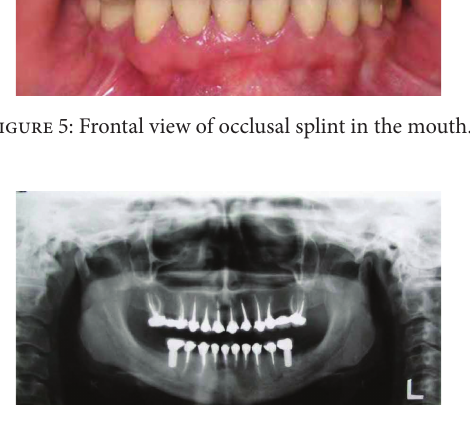
Figure 6: Posttreatment panoramic